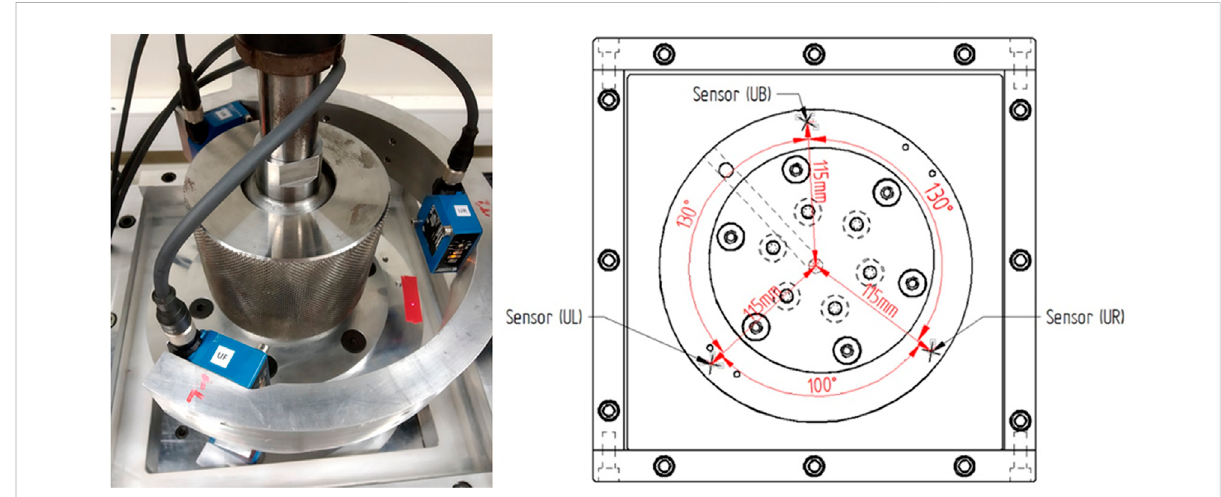
FIGURE 2 The cavity thickness is controlled by three laser sensors placed above the compaction